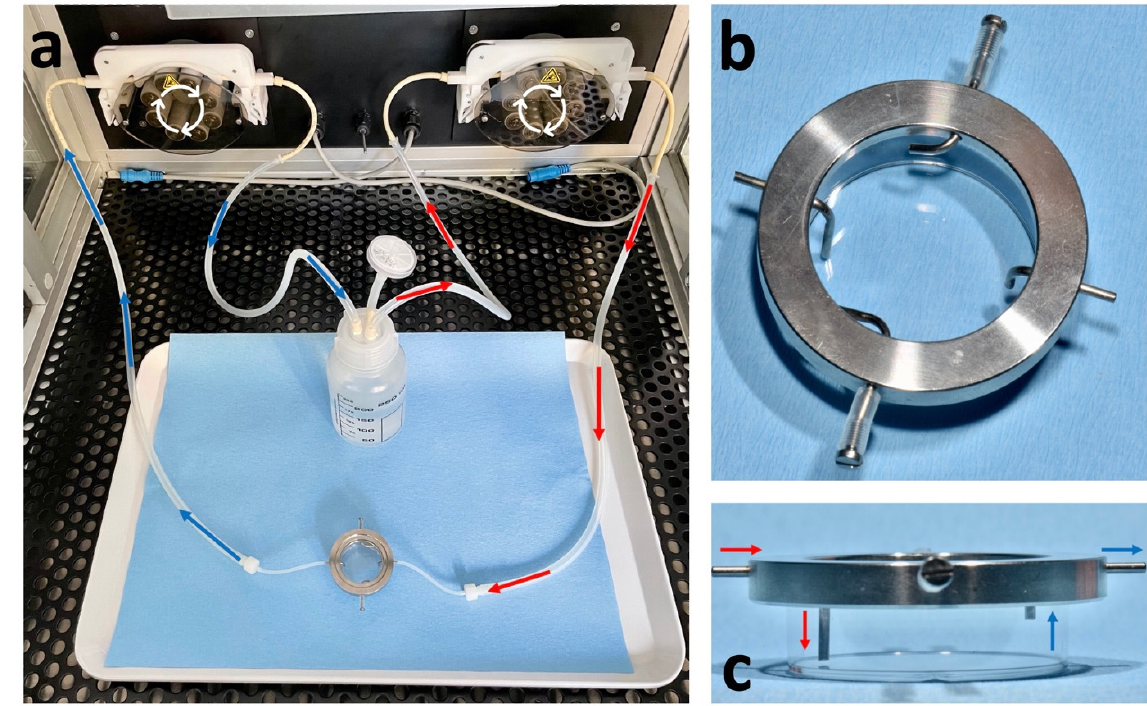
Figure 7. ( a – c ) Closed perfusion culture and dual perfusion set for 35 mm petri dishes. ( a ) Examples for a closed perfusion for one Petri dish. The inside of the bioreactor is shown. The red line shows the inlet, and the blue line shows the outlet. The tubes run through separate pump systems. This allows the outlet to be faster than the inlet and thus prevents the petri dish from overflowing; ( b ) top view; ( c ) side view of the dual perfusion set for 35 mm petri dishes. The system has a total of 4 inlets and outlets. In our case, only two were used, and the other two were closed. The red arrows show the influx, and the blue arrows show the outflux, including the height of the medium in the petri dish.